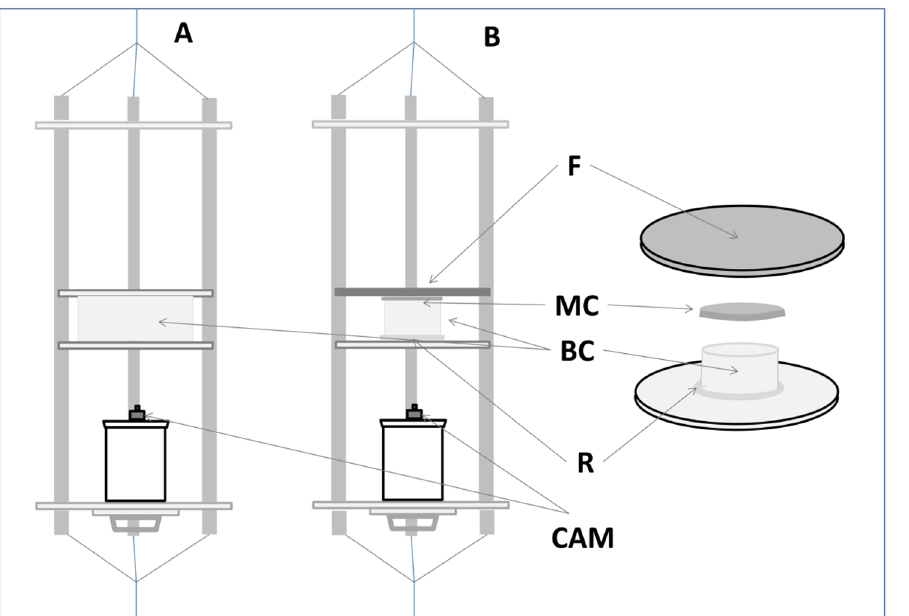
Figure 2. The DISC: Drifting In-Situ Chamber. The DISC is a cylindrical transparent and symmetrical behavioral chamber, which is set adrift and records the behavior of individual larvae (https://www.rsmas.miami.edu/users/cparis/instruments.html). (A) The classic DISC setup used in the natural conditions (NC) experiment consisting of a large behavioral chamber. (B) The setup used for the polarization manipulation experiment consisting of: the three layered filter (F), the mesh cover (MC), the behavioral chamber (BC), the acrylic ring (R), and the camera (CAM).